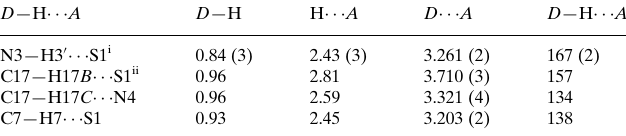
Hydrogen-bond geometry (A˚ , (cid:2)